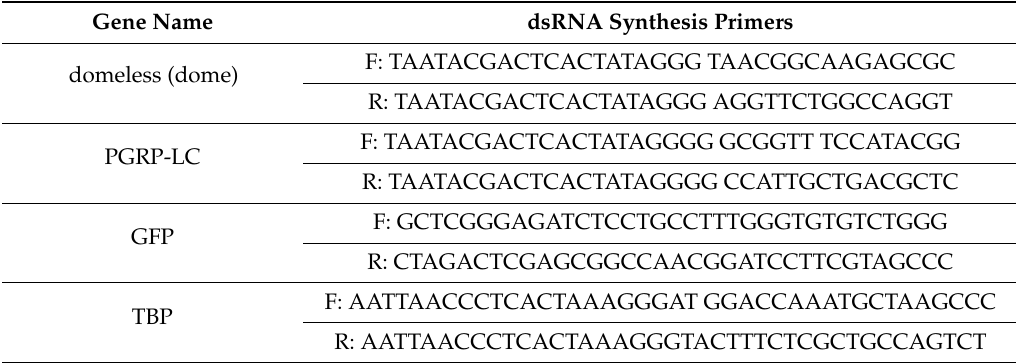
Table 1. Primer sequences for dsRNA